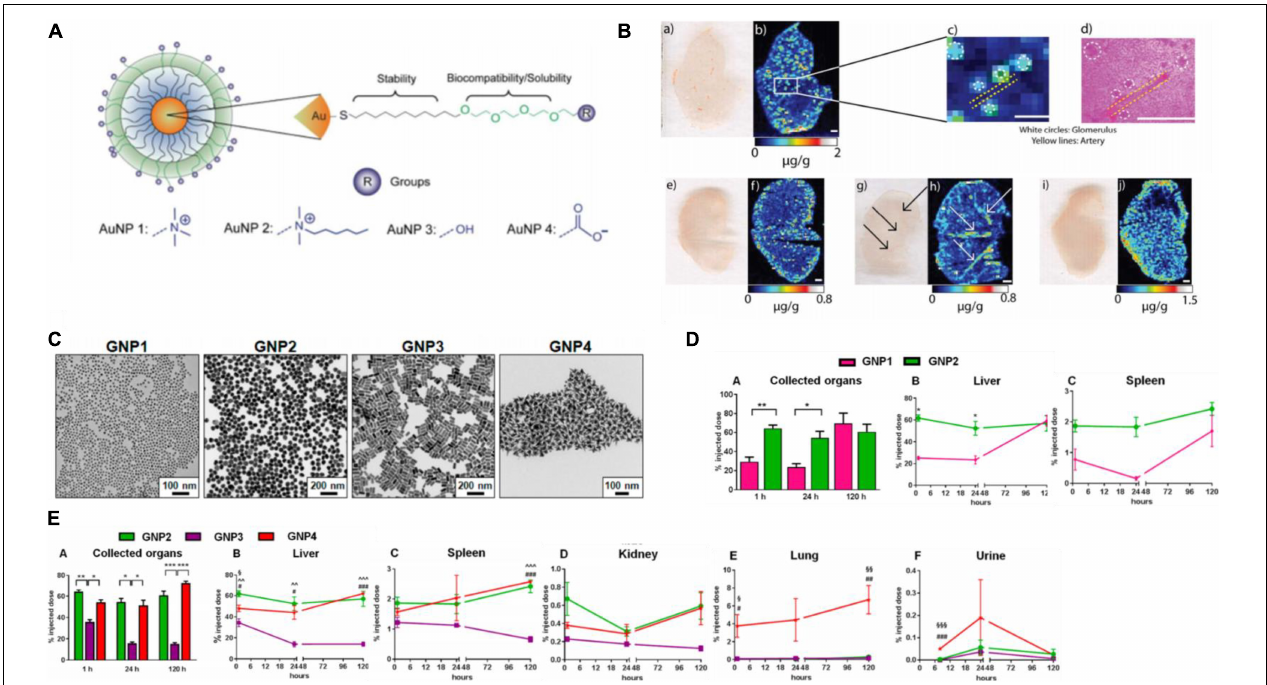
FIGURE 7 | (A) Structure of the different surface charge AuNPs. (B) Positively charged AuNPs (a,b,e,f) accumulated in glomeruli of the kidney tissues (c,d) , while neutral ones (g,h) were in arteries of the kidney, and negatively charged AuNPs (i,h) were more homogeneously distributed. Reprinted with permission from Elci et al. (2016). Copyright (2016), American Chemical Society. (C) TEM micrographs of the AuNP library. (D) (A) Different sizes influence thekinetics of AuNPs. (B,C) The larger size penetrated faster in organs and remained stable a long time. (E) The biodistribution (A) of three shapes AuNPs with similar size, spherical, and star-like AuNPs had similar behavior in filter organs (B–D) and higher penetration than rod-like AuNPs. Star-like AuNPs showed a high tropism for the lungs (E) and higher levels in urine (F) . * P < 0.05, ** P ≤ 0.005, and *** P ≤ 0.0005 ( ∧ GNP2 compared to GNP3, § GNP2 compared to GNP4, and #GNP3 compared to GNP4). Reprinted with permission from Talamini et al. (2017), Copyright (2017), American Chemical